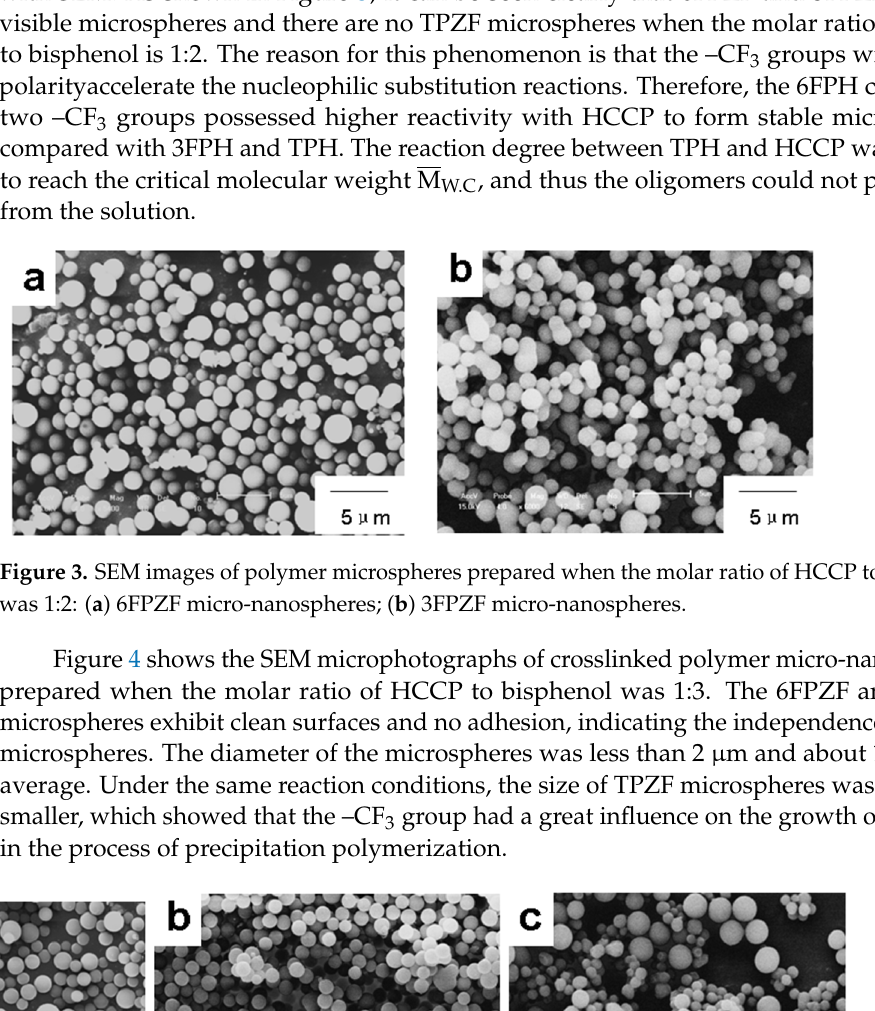
Figure 4. SEM images of polymer microspheres prepared when the molar ratioof HCCP to bisphenol was 1:3: ( a ) 6FPZF micro-nanospheres [21] Copyright © 2013, Springer-Verlag Berlin Heidelberg; ( b ) 3FPZF micro-nanospheres; ( c ) TPZF micro-nanospheres.